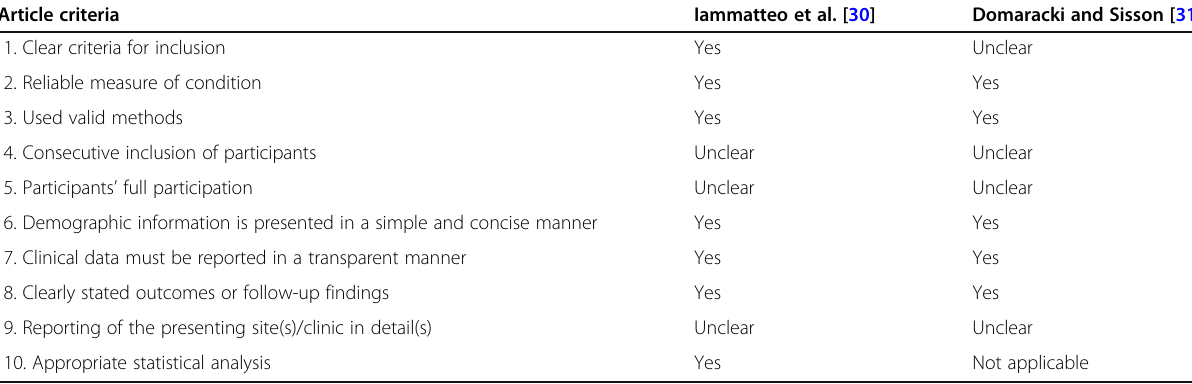
Table 6 Critical appraisal for case series studies: JBI Article